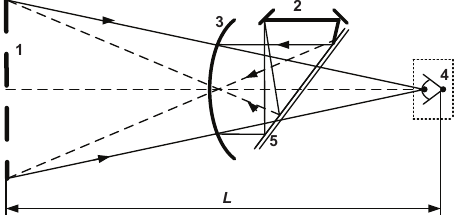
Fig. 3. Scheme of a narrow-angle 3D indicator based on a mirror collimator: 1 – the place where an imaginary image appears; 2 – the screen for formation of an intermediate image; 3 – the concave spherical mirror; 4 – the pupil of observation (where, when the eye is positioned, the observer sees a three-dimensional image); 5 – the beam splitter plate; L – the minimum distance from the appearance of the nearest three- dimensional